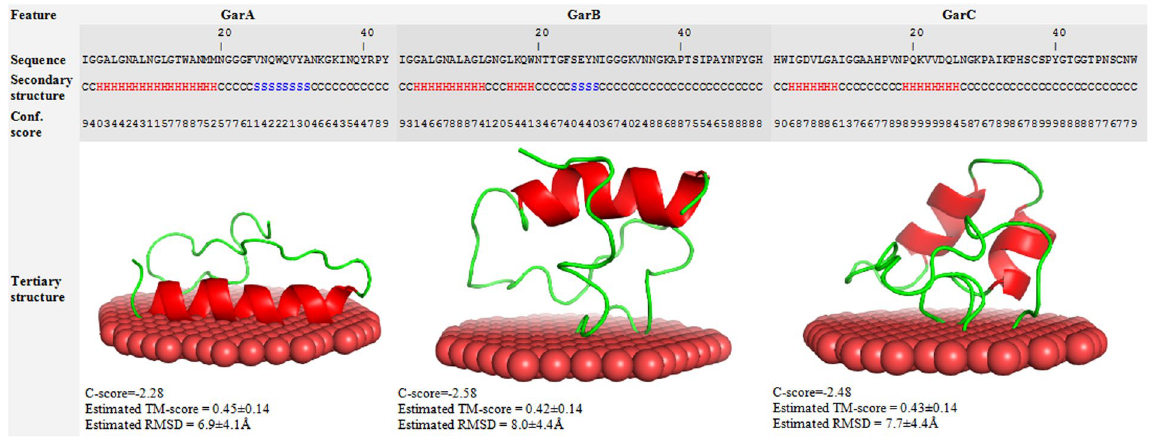
Figure 3. Predicted secondary and tertiary structures of GarA, GarB and GarC. H, S and C indicate helix, strand and coil, respectively. Confidence score range from 0 to 9 and represents certainty of the secondary structure prediction. C- and TM-scores estimate global accuracy of the 3D structure model. C-score in the range from − 5 to 2 and TM-score > − 1.5 indicates a model with correct global topology. Root mean square distance (RMSD) is the average distance of pairs of residues between model and template.